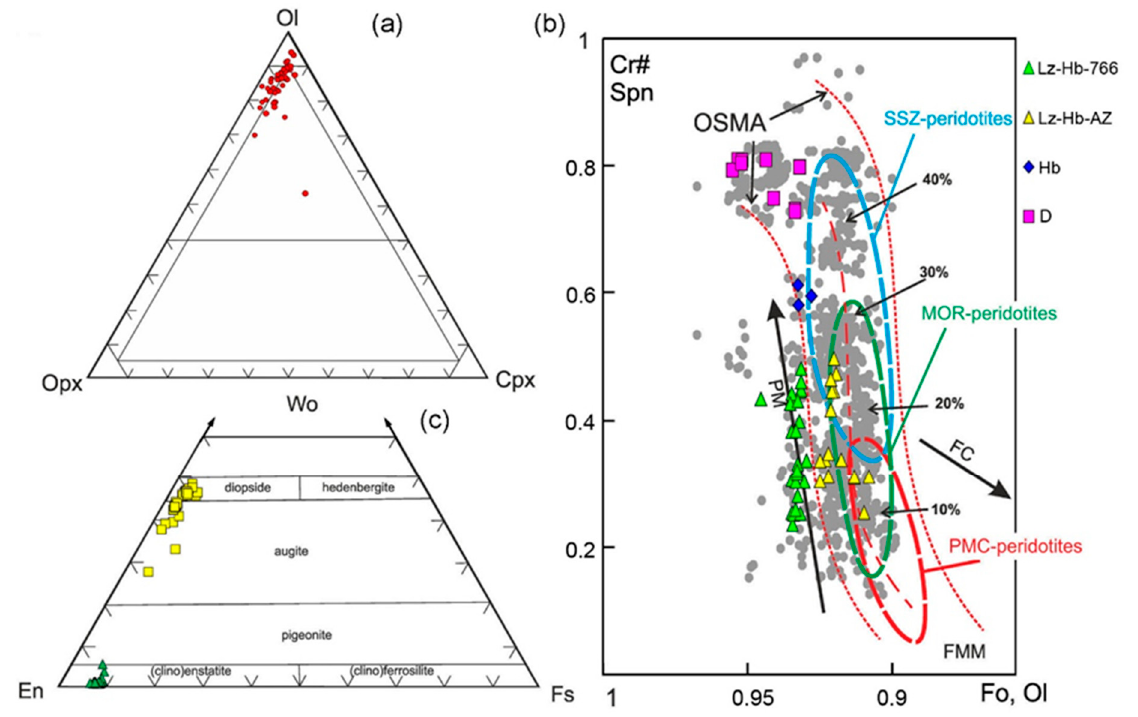
Figure 6. ( a )—Normative mineral compositions of peridotites inferred from chemical composition; ( b )—OSMA diagram for coexisting Ol and Cr-spl grains; here, percent notes partial melting degree in experiment after [40], that corresponds to Ol-Spl compositions in restite; gray points are Ol-Spl compositions in lherzolite-type massifs of South Urals after [41]; Lz-Hb-766—peridotite of well 766; Lz-Hb-AZ—peridotite from Almaz-Zhemchuzhina deposit area; Hb—harzburgite, D—dunite; ( c )—Compositions of Opx and Cpx on the triangular diagram En–Wo–Fs.